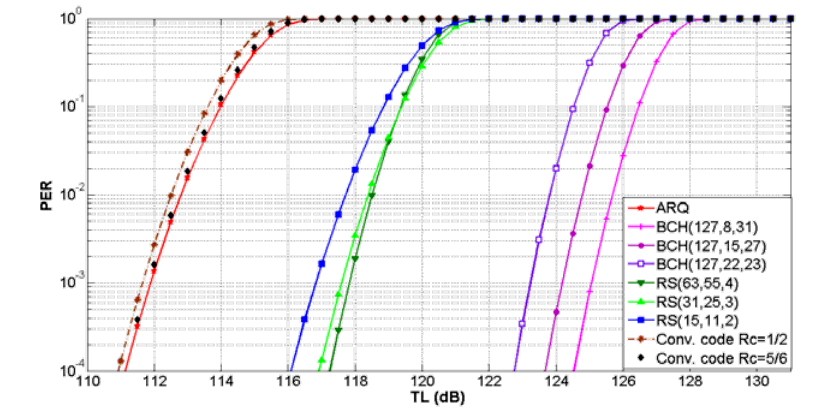
Figure 13. PER as a function of transmission loss for shallow water.